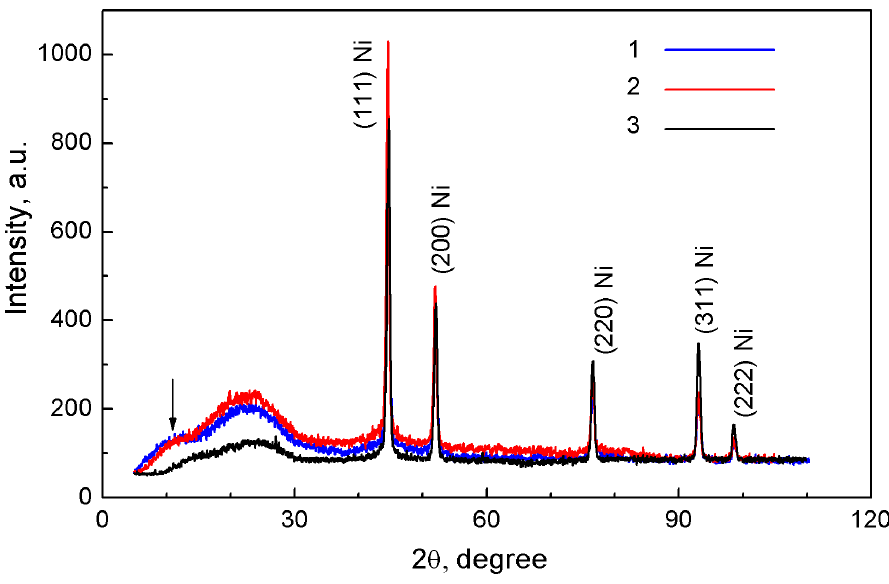
Figure 5. X-ray diffraction patterns of NC1_10 (1), NC1_5 (2), NC2 (3)